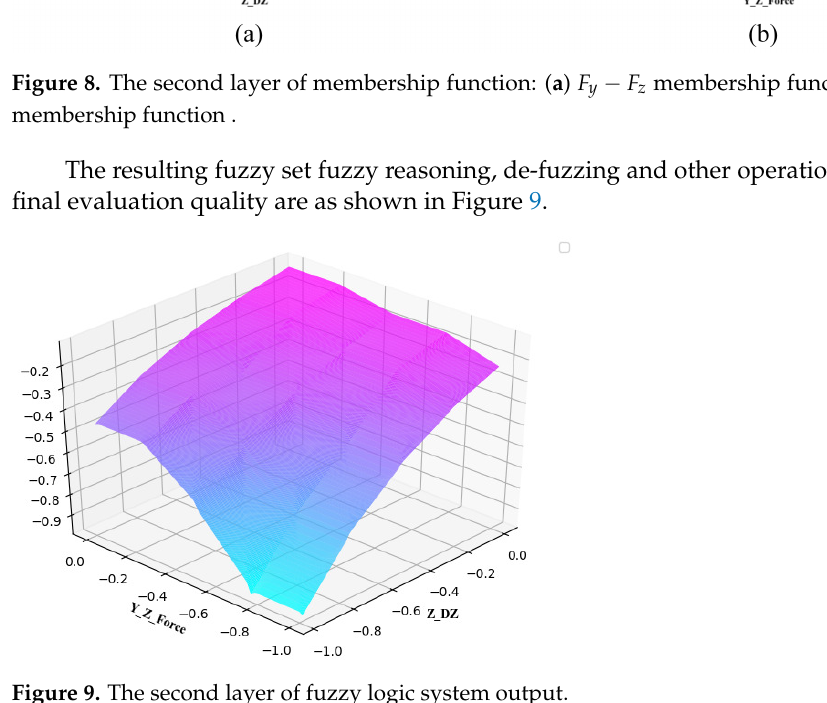
Figure 9. The second layer of fuzzy logic system output.